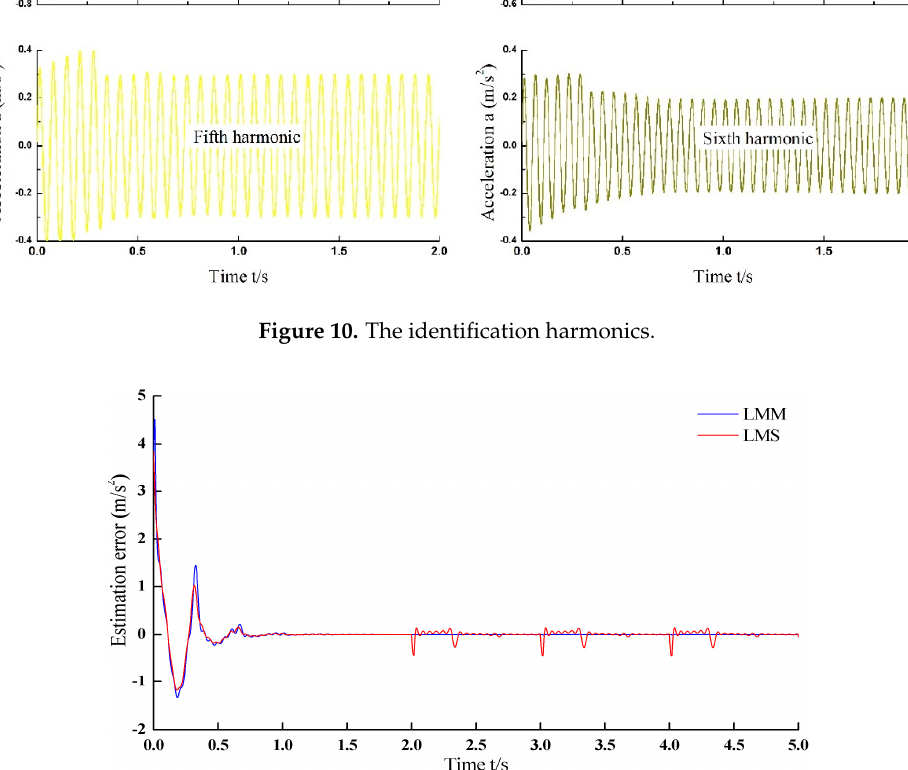
Figure 10. The identification harmonics.